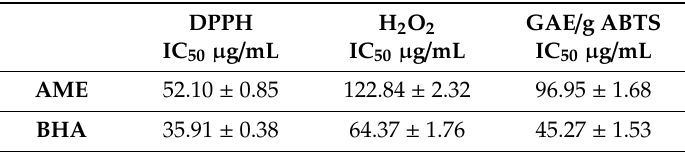
Table 2. In vitro antioxidant activity of AME extract.